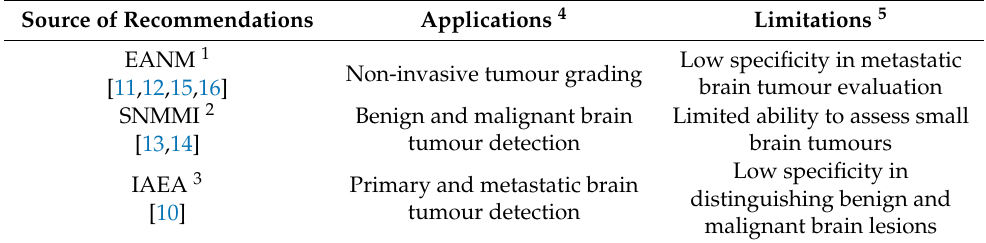
Table 1. [ 18 F]FDG PET/CT in brain tumour diagnosis—international societies’ recommendations. Source of